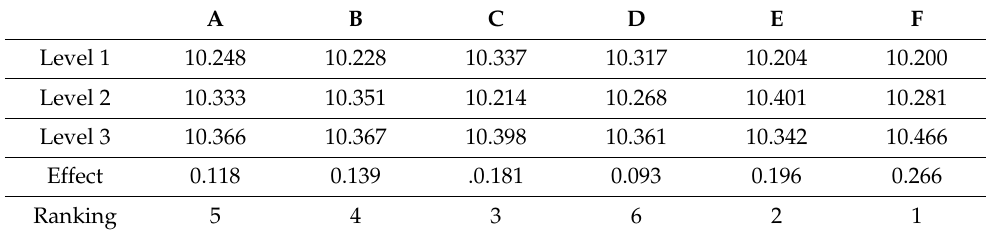
Table 8. The response table of the tensile strength.